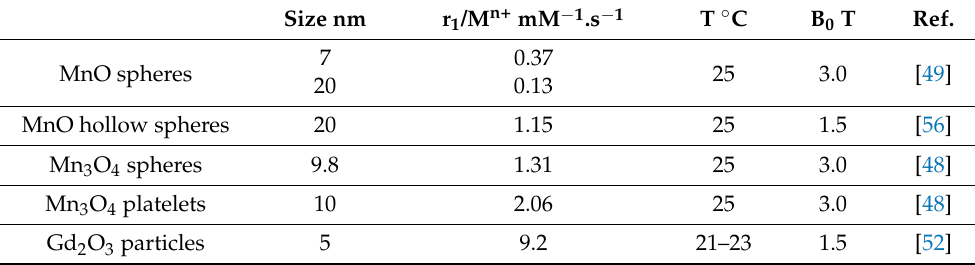
Table 2. Longitudinal relaxivity r 1 for different paramagnetic inorganic NPs under different MRI operating